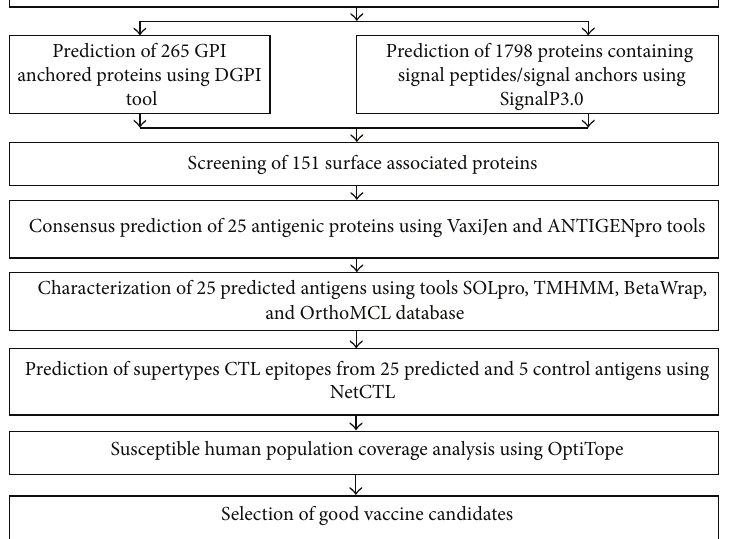
Figure 1: Flowchart depicting the steps adopted for genome-wide screening of potential antigens and their epitopes optimization.